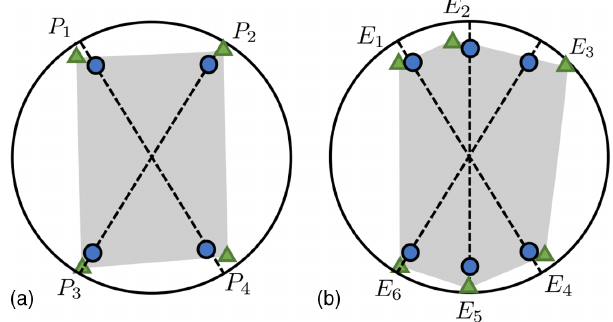
FIG. 8. (a) If one can perform the four primary preparations P 1 – P 4 (shown as green triangles), then one can simulate any preparation in their convex hull (shown as a light gray shaded region). In particular, one can simulate secondary procedures that are depolarized versions of the ideal preparations (shown as blue circles like those in Fig. 6). (b) Similarly for the